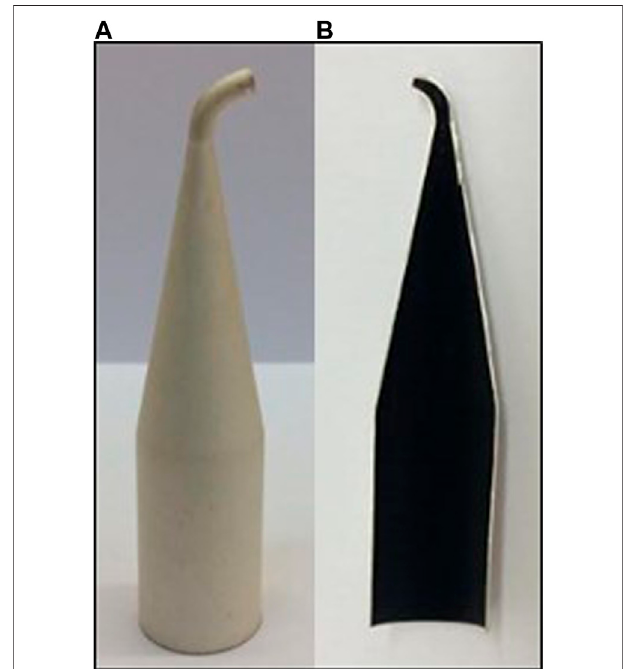
FIGURE7 | Silver cavity with tube at the apex ofthe cone (A) and cross- section coated with ultra-black Ni-P (B)